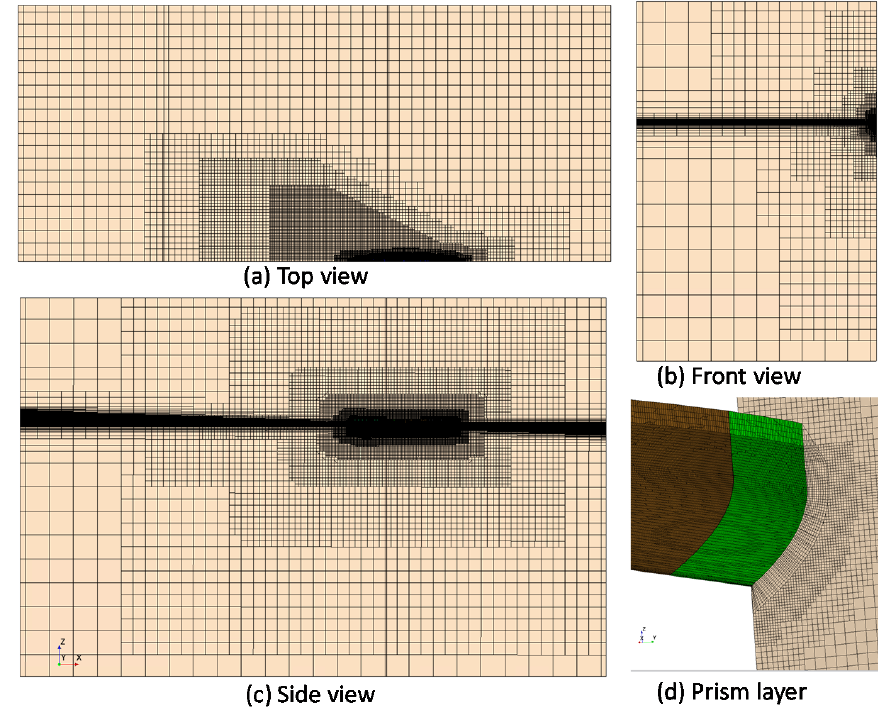
Figure 5. Volume mesh of the Wigley hull simulation.